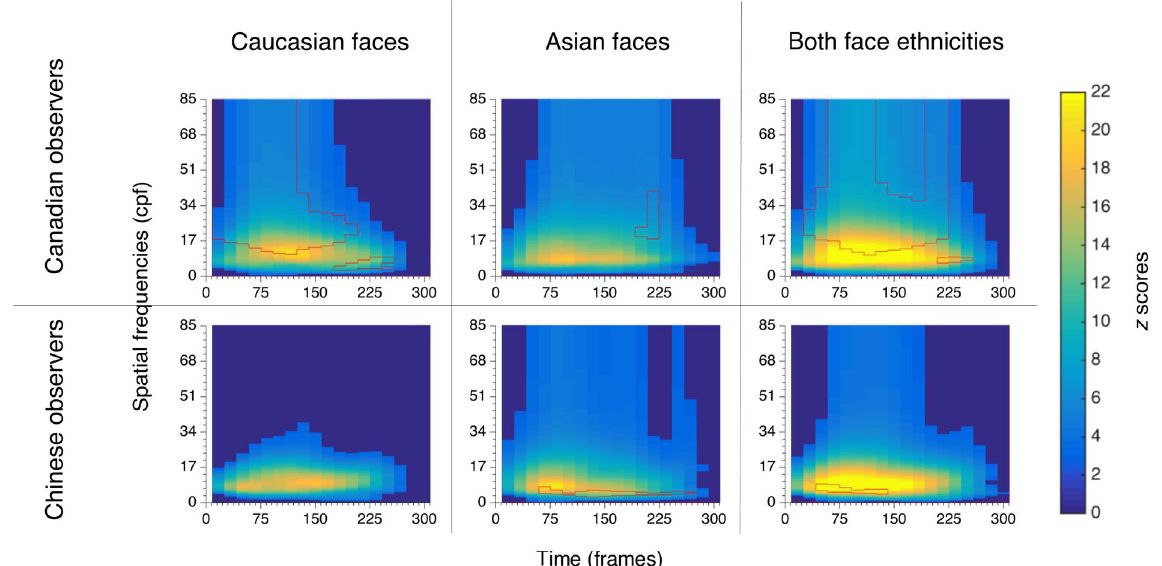
Figure 2. Classification images illustrating Canadian and Chinese observers’ significant use of spatial frequencies across time, for Western Caucasian faces, East Asian faces and both face ethnicities combined. Group differences (i.e. Canadian observers - Chinese observers) are marked for each group and stimulus category: red edges delineate significant SF use biases for each cultural